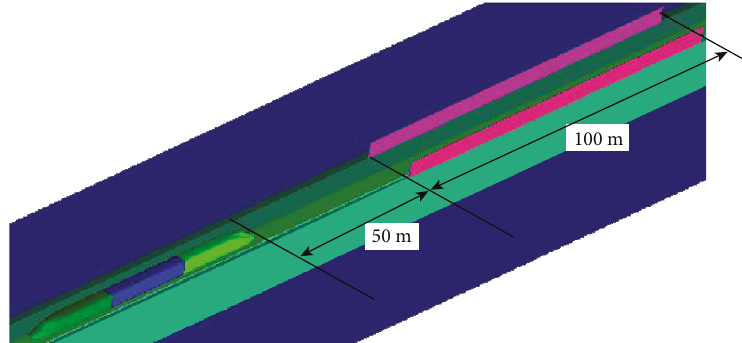
Figure 3: Geometric positions for a high-speed train passing the embankment air barriers.